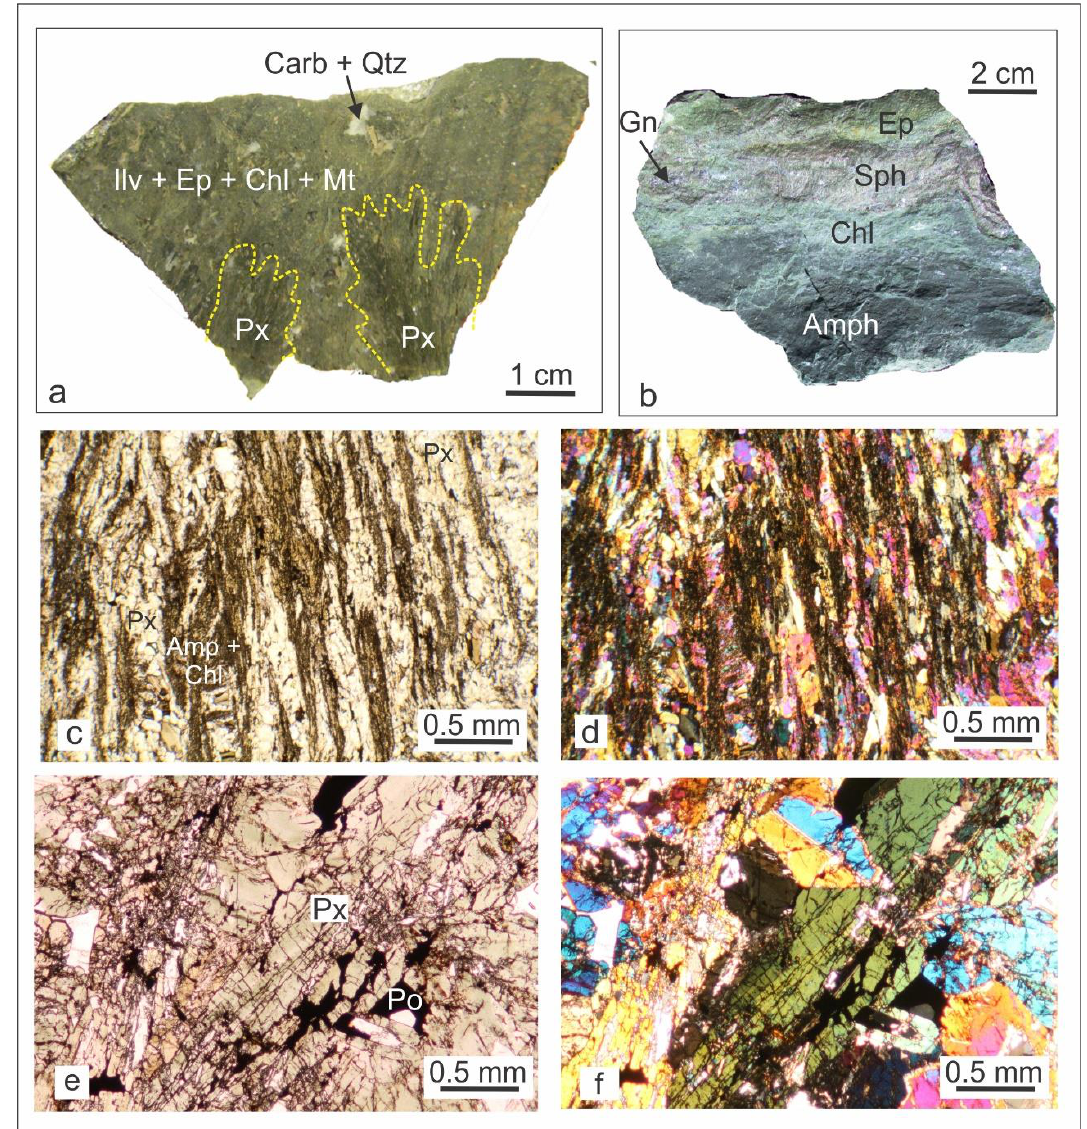
Figure 5. ( a ) Hand-specimen showing the transition from the prograde (anhydrous silicate- dominated) stage to the retrograde (hydrous silicate- dominated) stage; ( b ) Hand-specimen showing the rhythmic bedding of the retrograde/hydrothermal mineral paragenesis; ( c ) Transmitted light photomicrograph of the retrograde mineralization mimicking prograde fibroradial texture (plane polarized light); ( d ) Transmitted light photomicrograph of the retrograde mineralization mimicking prograde fibroradial texture (crossed polars); ( e ) Transmitted light photomicrograph of prograde pyroxene partly replaced by pyrrhotite (plane polarized light); ( f ) Transmitted light photomicrograph of prograde pyroxene partly replaced by pyrrhotite (crossed polars). Abbreviations: Px — pyroxene; Amph — Amphibole; Chl — chlorite; Sph — Sphalerite; Ep — epidote; Po — pyrrhotite; Py — Pyrite.